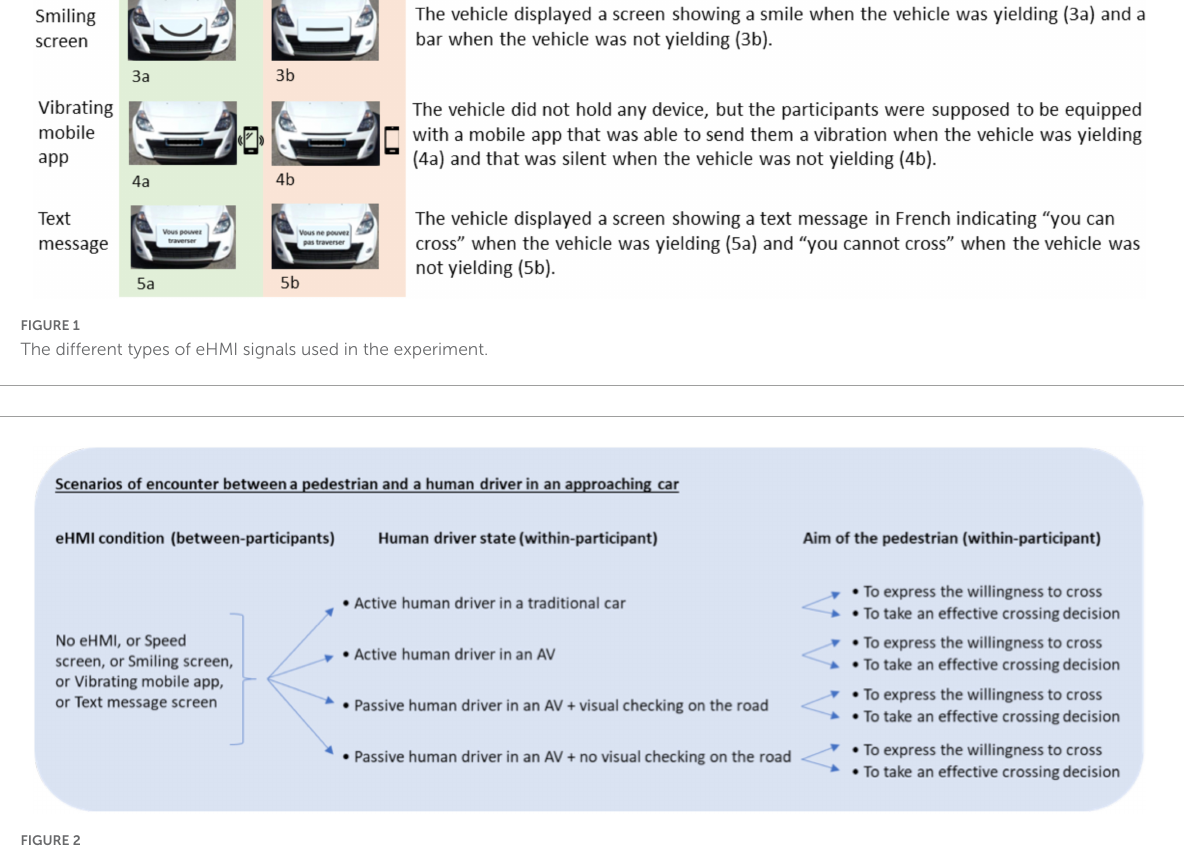
FIGURE2 Independent variables manipulated in the four scenarios of encounters between a pedestrian and a human driver in an approaching car, with regard to the aim of the